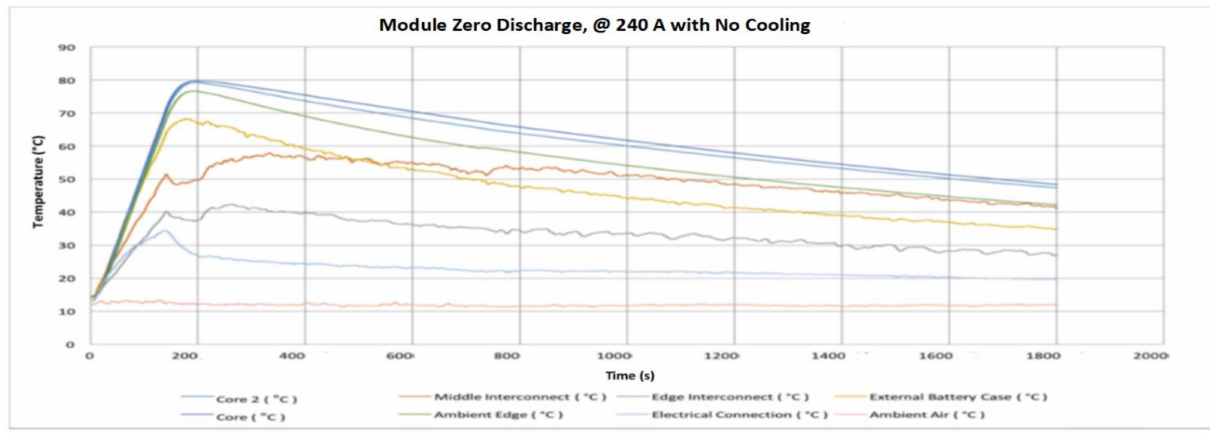
Figure 13. Module zero discharge, 240 A with no